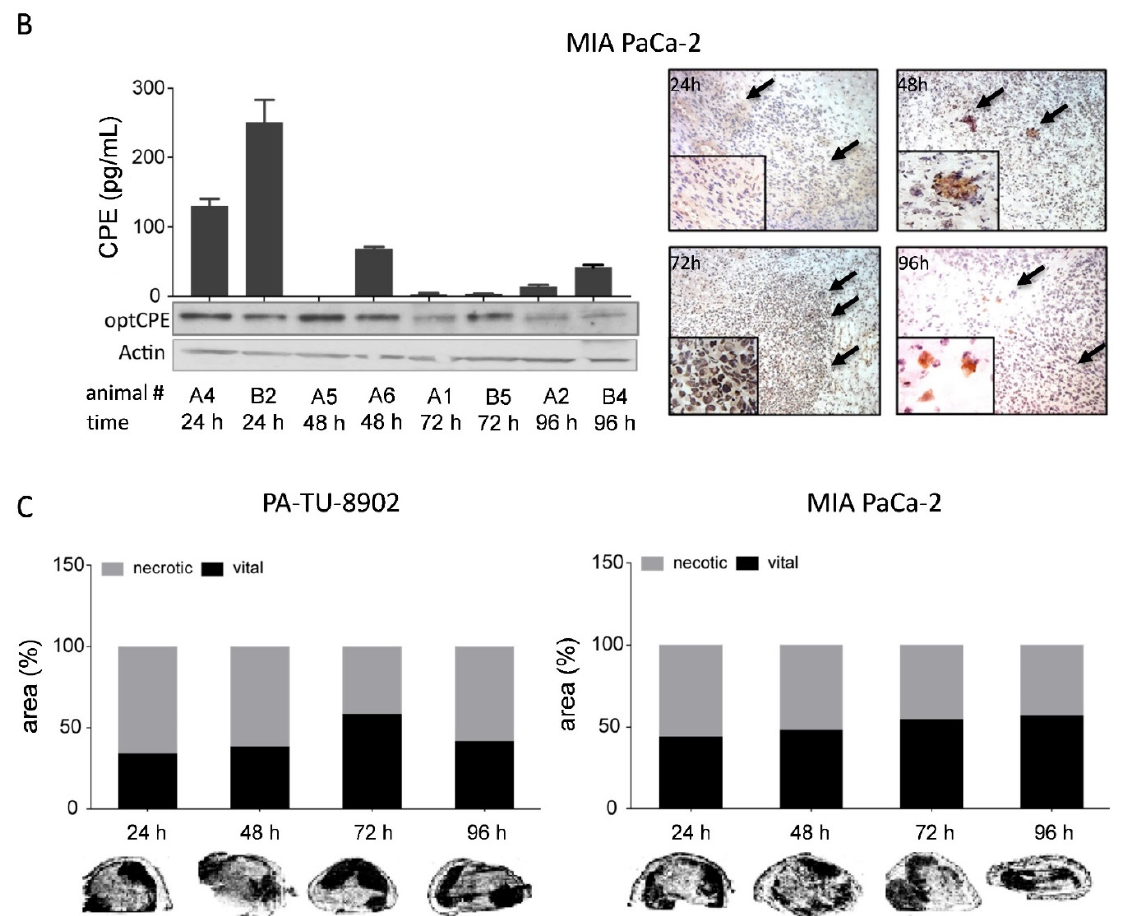
Figure 5. Analysis of optCPE expression in CDX tumor tissue after non-viral in vivo jet-injection gene transfer. ( A ) Time dependent optCPE expression after in vivo gene transfer was analyzed in PA-TU-8902 or MIA PaCa-2 CDX. At indicated time points mice were sacrificed and tumors removed. Western blot analysis (Figure S8) and CPE quantification via CPE ELISA revealed in vivo optCPE expression in both models at all time points (left panel), supported by CPE-specific immunohistochemistry (right panel). ( B ) MIA PaCa-2 tumors demonstrated strong optCPE expression 24–48 h after gene transfer (Figure S8), confirmed by brown staining of CPE-specific immunohistochemistry (right panel, indicated by arrows, 20-fold magnification). ELISA data are represented as mean values ± S.E.M. ( C ) Necrotic areas of optCPE-transfected tumors were analyzed. Tissues were HE stained and ratios of vital vs. necrotic areas were quantified for indicated time points. PA-TU-8902 and MIA PaCa-2 CDX tumors showed massive necrotic areas (grey) surrounded by residual vital tumor tissue (black).